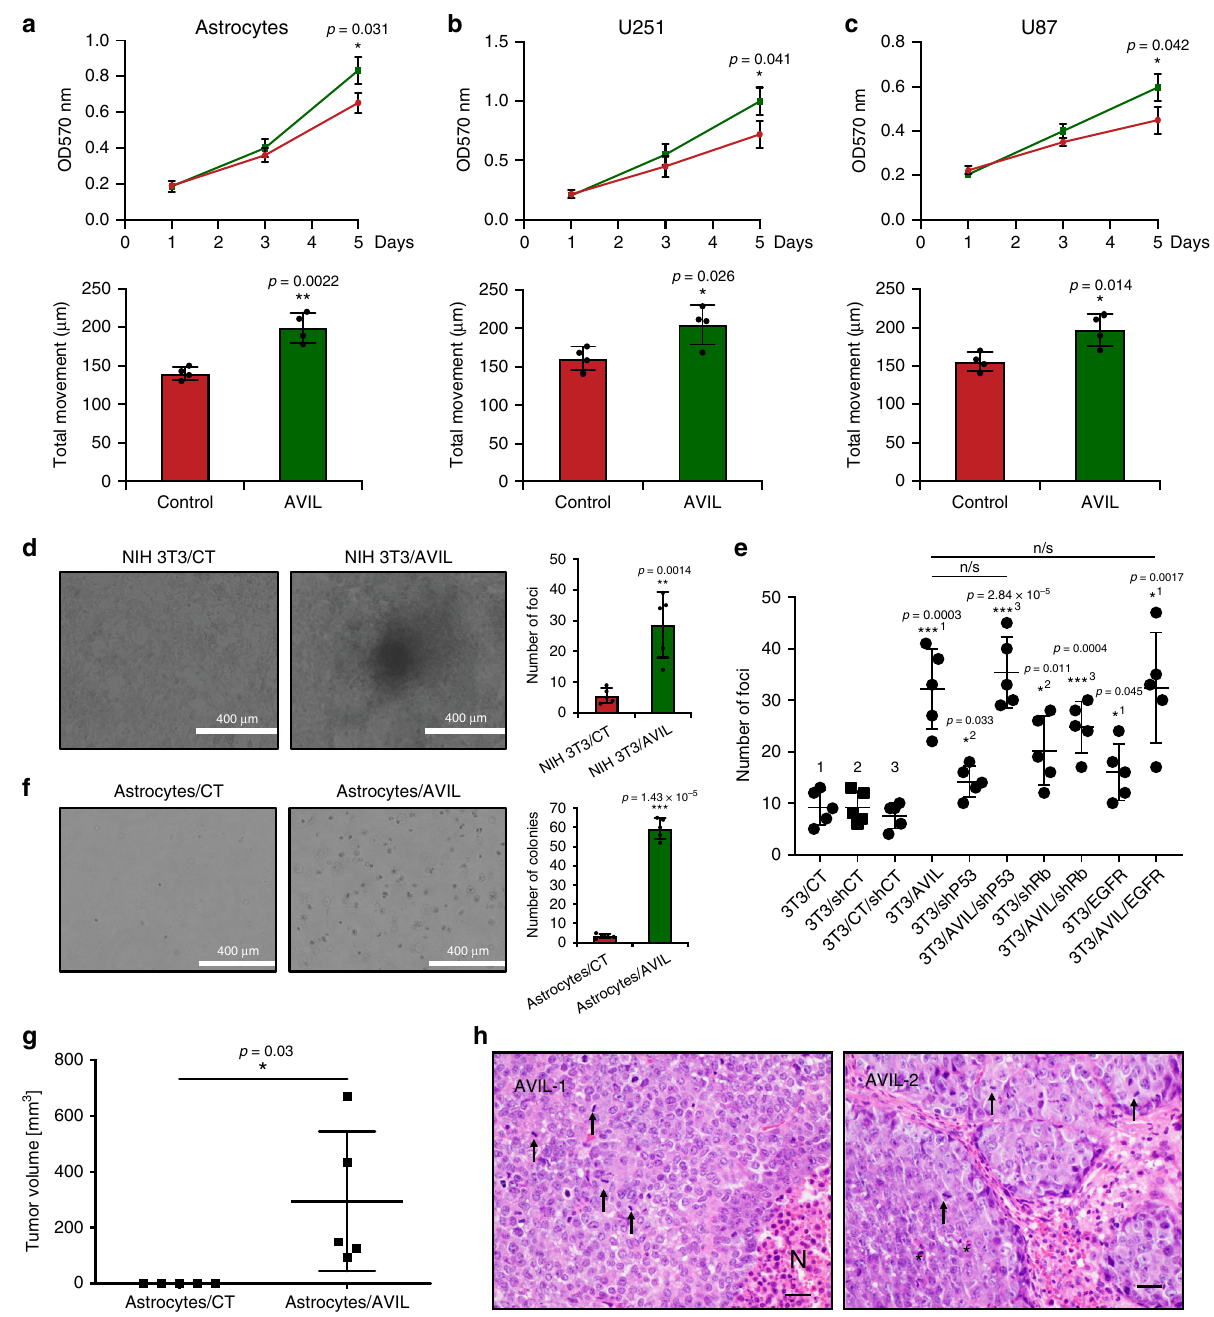
Fig. 5 AVIL overexpression promotes tumorigenesis. Overexpressing AVIL with Myc-tagged AVIL in astrocytes ( a ), U251 ( b ), and U87 ( c ) resulted in increased cell proliferation, assayed by MTT (upper), or cell motility, assayed by wound-healing (lower). P value was calculated by standard two-tailed t -test. d Focus assay. NIH-3T3 cells were transfected with AVIL expressing (AVIL) or control empty plasmid (CT). Representative image is shown. Two- sided Student ’ s t- test. e Quanti fi cation of foci resulted from oncogene cooperation assays. NIH-3T3 cells were transfected with shP53, ShRB, EGFR VIII mutant with or without AVIL overexpression. Two-sided Student ’ s t- test. 1, 2, and 3 groups are compared to the corresponding controls. f Soft-agar assay showing that astrocytes transfected with AVIL formed a much larger number of colonies compared with those transfected with empty vector control (CT). P value was calculated by standard two-tailed t-test. g Measurement of the tumor volume. No tumor was formed in the CT group. h Representative hematoxylin and eosin staining of the tumors harvested from the mice. Histology analysis revealed neoplasms with histologic features of malignancy including necrosis (N), frequent mitotic fi gures (arrows), and apoptotic fi gures (asterisks). * p < 0.05, ** p < 0.01, *** p < 0.001. Data are presented as mean values ± SD in a – f , and h . a – c , n = 4; D-G, n = expressed Myc-tagged AVIL, either wild-type or mutants, in glioblastoma cells in which endogenous AVIL was silenced and performed co-immunoprecipitation with anti-Myc antibody to assess the interaction between actin and AVIL mutants. The